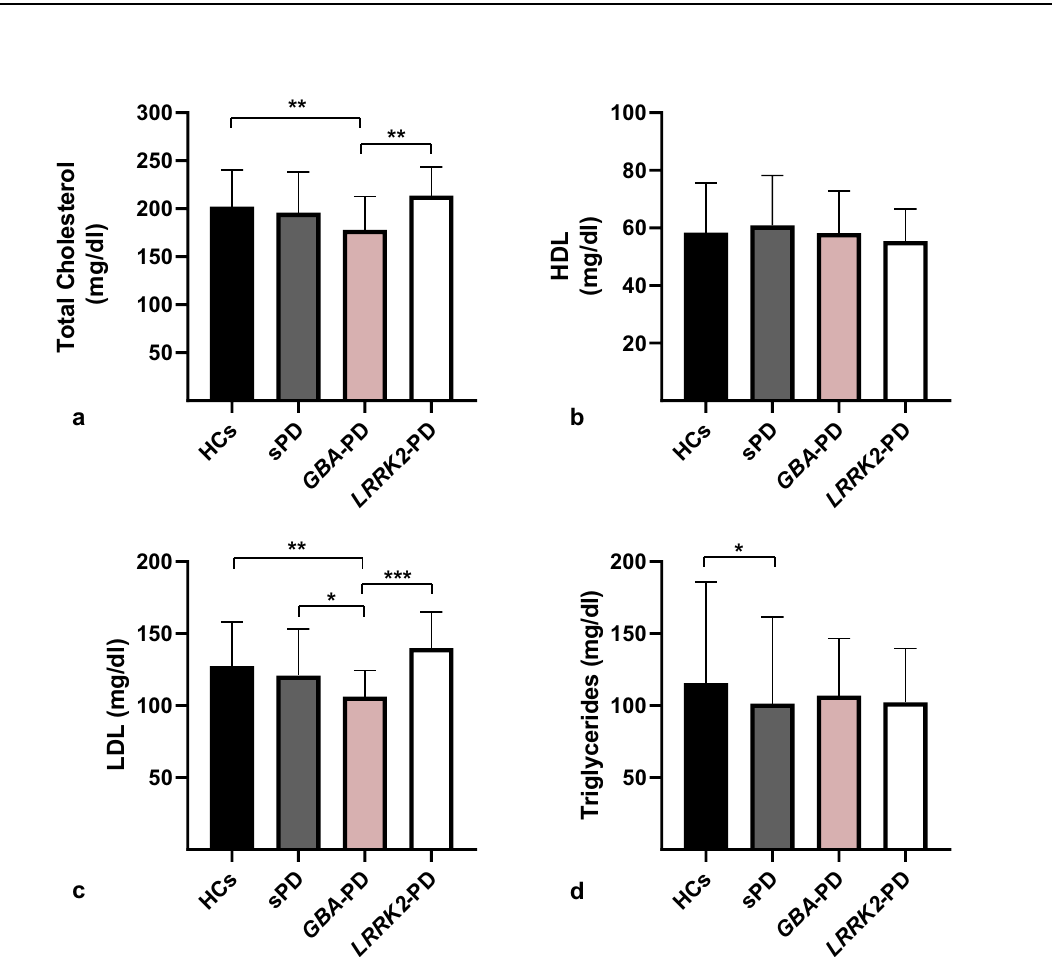
Fig. 1 Serum lipid pro fi le among Parkinson ’ s disease cohorts and healthy controls. Multiple comparisons of total cholesterol ( a ), HDL ( b ), LDL ( c ), and triglycerides ( d ) levels among healthy controls (HCs), sporadic Parkinson ’ s disease patients (sPD), GBA -associated Parkinson ’ s disease patients ( GBA -PD), and LRRK2 -associated Parkinson ’ s disease patients ( LRRK2 -PD). Numbers shown as means ± SD with one-way ANCOVA with post hoc testing for multiple comparisons as appropriate. *** p <0.005, ** p <0.05, * p < 0.1.